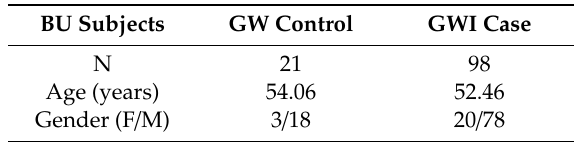
Table 1. Subject